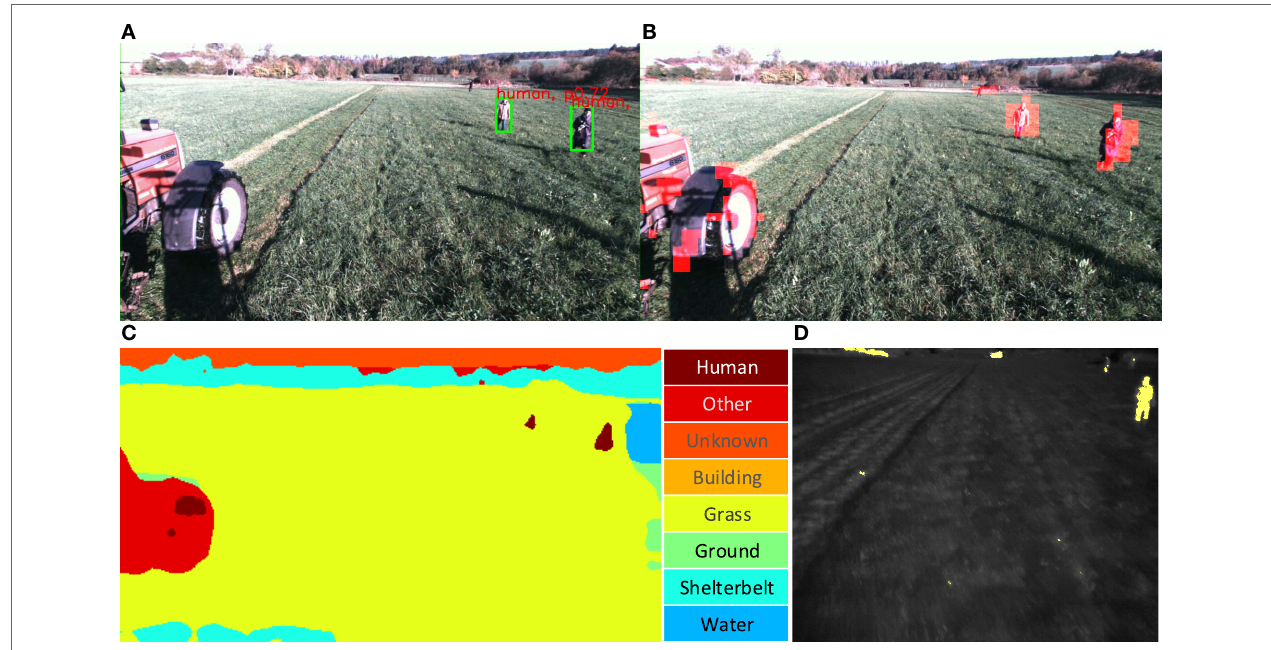
FIGURE 4 | Camera detections for stereo and thermal camera. Written and informed consent was obtained from all depicted individuals. (A) Object detection using YOLO. (B) Anomaly detections (highlighted with red) using DeepAnomaly. (C) Semantic segmentation using FCN. (D) Thermal camera detections (highlighted with yellow) using